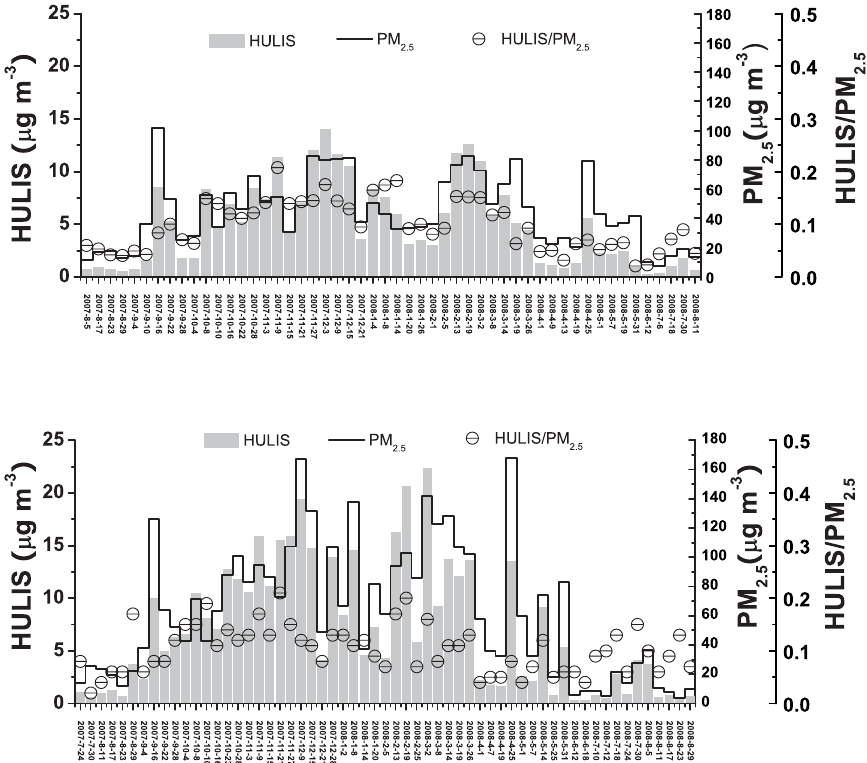
Fig. 2. Time series of HULIS, PM 2 . 5 mass concentrations, and the relative abundance of HULIS in PM 2 . 5 mass measured at the urban site (top) and suburban site